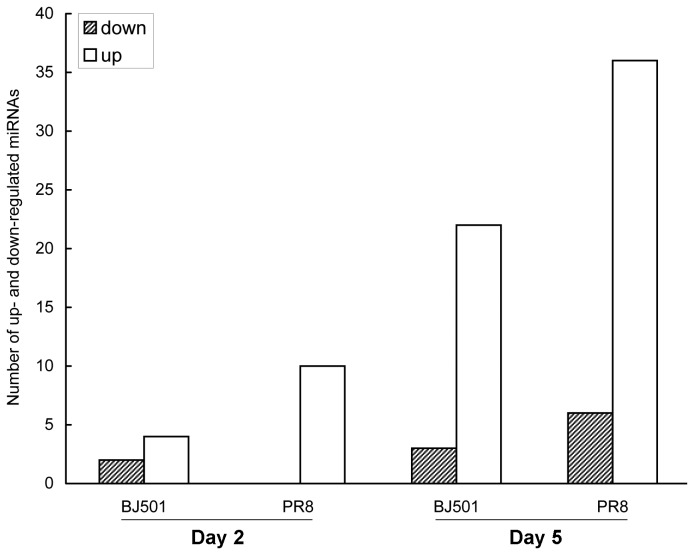
The number of differentially expressed microRNAs during influenza virus BJ501 and PR8 infections.The y axis indicates the number of differentially expressed microRNAs. Significance was determined using a fold-change threshold of at least 2 and a nominal P value cutoff of 0.05.